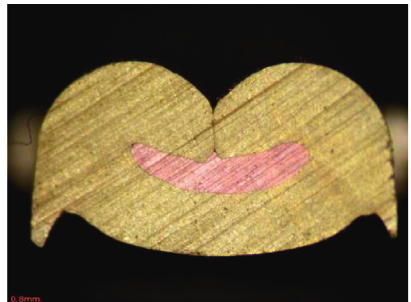
Figure 10: Crimp at a height of 1.20mm.